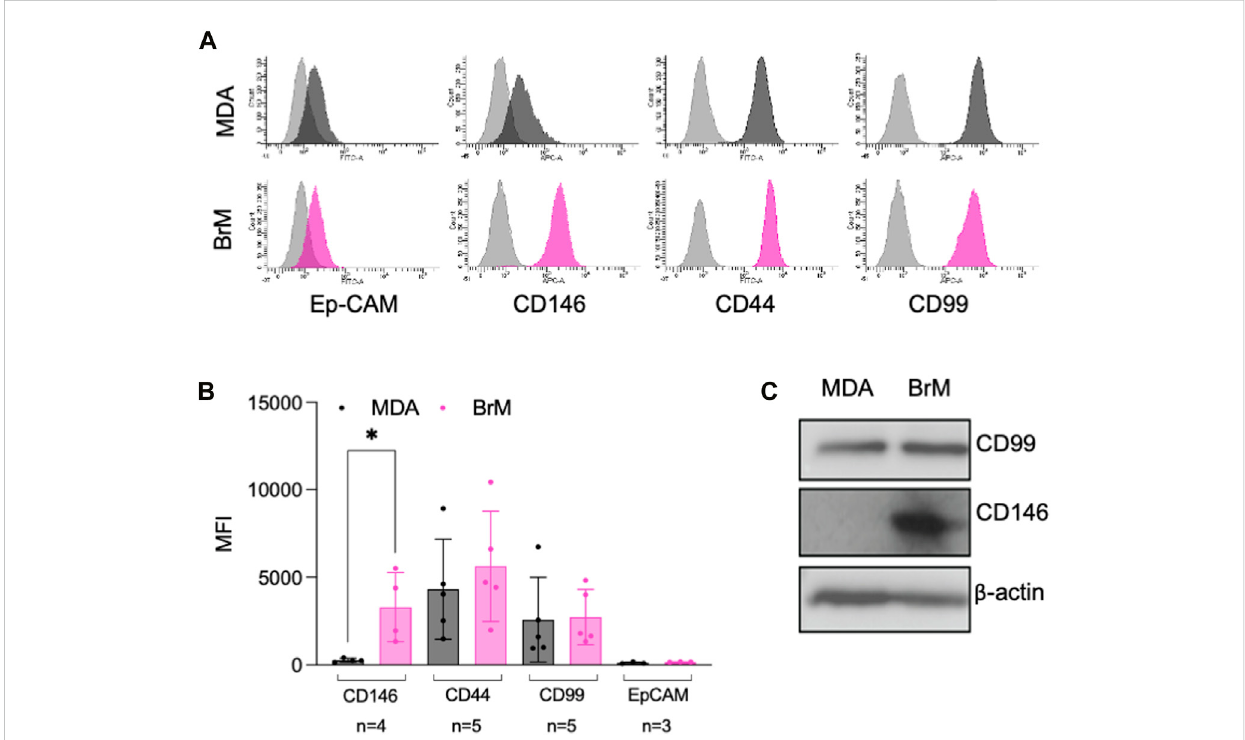
FIGURE 2 MCAMishighlyexpressedbybrainmetastaticvariantofbreastcancer (A) Expression ofcellsurfaceCD146,CD44,CD99andEp-CAMonMDA(dark grey histograms) and MDA-BrM (pink histograms) determined by fl ow cytometry compared to the isotype control (light grey histograms). This data is representative of a minimum of 3 independent experiments. (B) Quanti fi cation of fl ow cytometry data shown in (A) . The graph shows quanti fi cation of indicated receptor normalised to isotype controls with the number of independent experiments (n) used to measure expression of each antigen shown. Error bars indicate S.D. Analysis was performed using multiple unpaired T testing; * p < 0.05, ns, not signi fi cant. (C) Expression of total CD146 and CD99 protein expression determined by Western blotting in MDA and MDA-BrM using anti-CD146 and anti-CD99 antibody and anti- β actin as a loading control. This data is representative of two independent